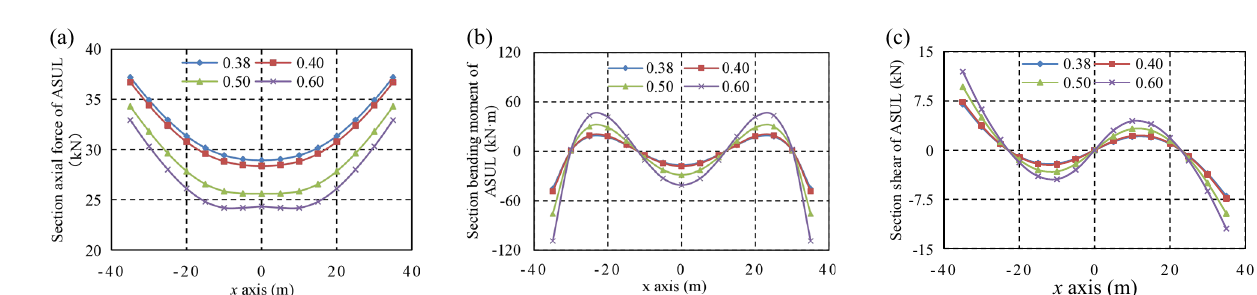
Figure 7. Internal force distribution of the ASUL under different rise-to-span ratio: ( a ) axial force, ( b ) bending moment, ( c ) shear Horizontal pressure coefficient of the ASUL. The internal forces in the cross-section of the ASUL under different horizontal pressure coefficients for an overlying load of 1.0 kN/m and rise-to-span ratio of 0.38 are shown in Fig. 6. The axial force and bending moment are symmetrically distributed, while the shear force is anti-symmet- rically distributed. When the horizontal pressure coefficient is less than one, the overlying load on the ASUL is greater than the horizontal load. When the horizontal pressure coefficient is greater than one, the overlying load is less than the horizontal load. (1) When the horizontal pressure coefficient is < 1 and increases from 0.30 to 0.54, the horizontal load is lesser than the overlying load. Further, the change in the axial force, bending moment, and shear force is smaller. The axial force is greater than the bending moment, which is greater than the shear force. Additionally, the axial force gradually increases from the dome to the base of the arch. The bending moment is the largest at the base, followed by the spandrel, and smallest at the dome. Accordingly, the shear force is the largest at the base, followed by the spandrel, and zero at the dome. (2) When the horizontal pressure coefficient is > 1 and increases from 2.00 to 3.00, the horizontal load is greater than the overlying load. ASUL is primarily affected by the horizontal load and bending moment. The bending moment is greater than the axial force, which is greater than the shear force. The axial force decreases gradually from the dome to the base of the arch due to the horizontal load when the horizontal pressure coefficient is less than one. (3) As the horizontal pressure coefficient increases, the bending moment significantly increases at the dome, spandrel, and base of the arch. The bending moment at the dome, spandrel, and base of the arch increases